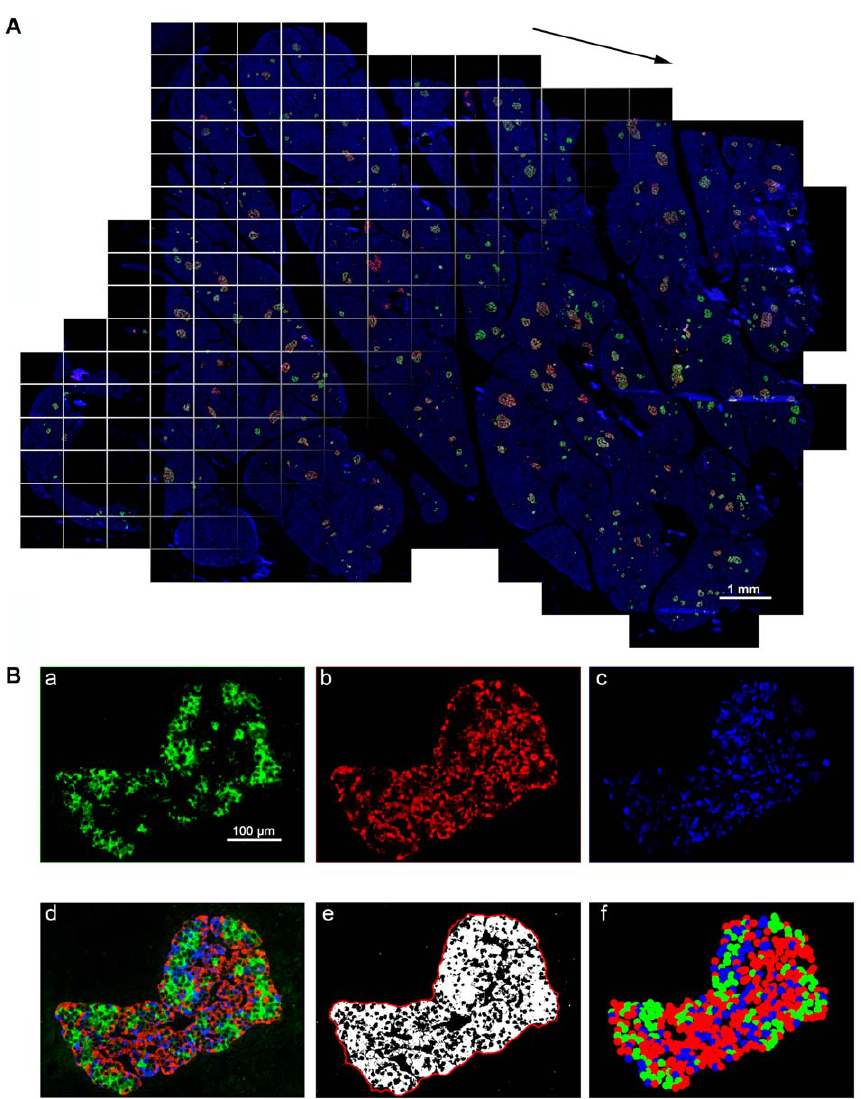
Figure 1. Large-scale capture and computer-assisted semi-automated analysis of the whole tissue section. A : Virtual slice view of a human pancreatic section (ND11) immunostained for insulin (green), glucagon (red), somatostatin (white) and nuclei (blue). A series of contiguous images of a specimen is collected (illustrated as boxed panels) and merged into a single image montage (i.e. virtual slice; arrowed). A composite is made by merging four overlapping virtual slice images. B : Views of each channel showing cellular composition. a. beta-cells, b. alpha-cells, c . delta- cells, and d. composite of all three endocrine cells. Note that there is no overlap among the endocrine cell fractions. Corresponding converted 8-bit masks after automatic thresholidng are shown in e . A contour shown in e (a red line) is used to measure islet area, which includes non-labeled area (e.g. capillaries). Based on the captured center coordinates of each cell type within the given islet, its architecture is reconstructed in f .